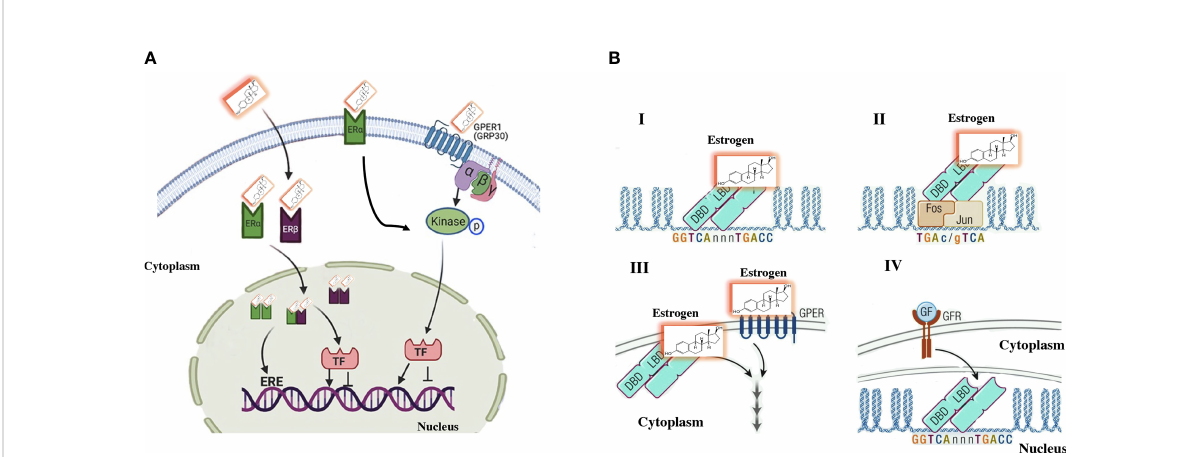
FIGURE 1 Traditional estrogen signaling mechanisms. (A) Genomic signaling: Estrogens cross the plasma membrane where they bind to estrogen receptors (ERs) in the cytoplasm. The estrogen – ER complex moves into the nucleus, where it forms homodimer and/or heterodimer complexes. These complexes bind to speci fi c estrogen-sensitive elements (EREs) in DNA or recruit transcription factors. Nongenomic signaling: Estrogens can perform a non-genomic effect by binding to their own receptors located on the plasma membrane. Additionally, some ER a is in the plasma membrane that induce the signaling cascade. (B) A more direct characterization of the effects of estrogen signaling observed in (A) I. The genomic activity of estrogens includes the binding of ERs to EREs in the regulation area of genes. II. Mechanism that involves an indirect activity of estrogens include an indirect activity on gene regulation by binding to other transcription factors, such as the AP-1 DNA sequence that binds to dimers of FOS/JUN. Therefore, ER a is “ bound ” to DNA by the binding of FOS/JUN to its DNA motif AP-1. III. Non-genomic information is established by extracellular signaling that stimulates second messengers in the cytoplasm, there is not direct interreference on gene activity. Responses are mediated by speci fi c G-protein coupled receptors or estrogen receptors on the membrane. IV. ER can be subject to ligand-independent activation by growth factor-mediated signaling that triggers the activation of intracellular signaling via the cell membrane receptor (GFR), which activates signaling pathways such as MAPK. The signal is mediated by estrogen receptors, which modulate the activity of speci fi c genes. Modi fi ed